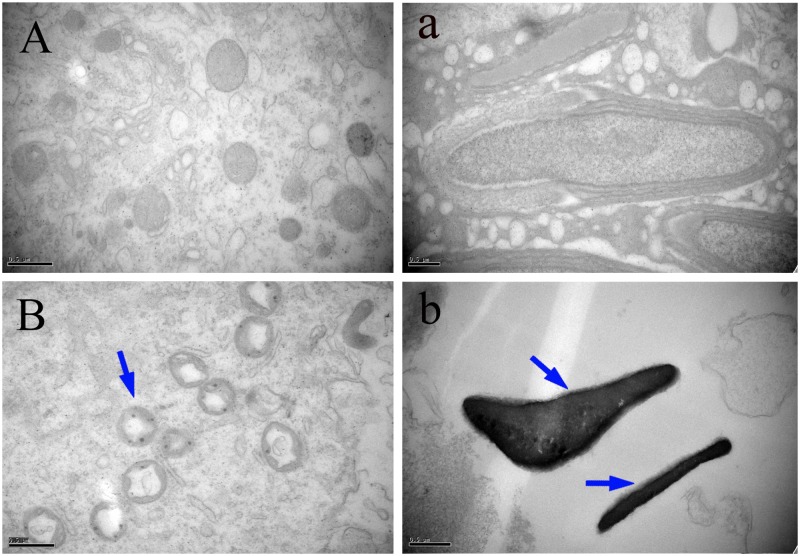
Effect of MEQ on the ultrastructure of mitochondria and sperm under TEM (Scale bar = 0.5 μm). (A) Mitochondria from the control group. (B) Mitochondria from the 110 mg/kg MEQ group. Arrow shows swelling, vacuoles and loss of crests. (a) Sperm from the control group. (b) Sperm from the 110 mg/kg MEQ group. Arrows show abnormal morphology, rupture and dissolution of the membrane.